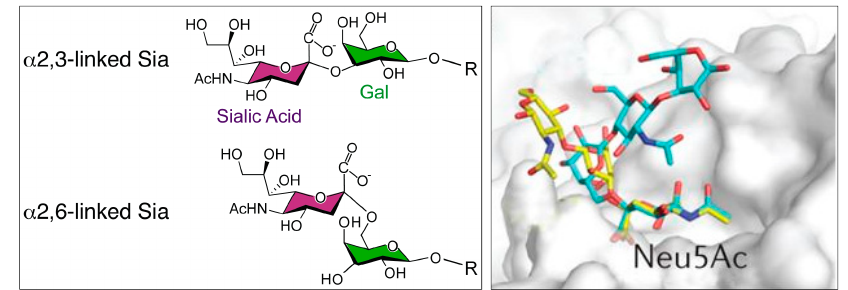
Figure 1. ( Left ): Structure of N -acetylneuraminic acid (Neu5Ac, sialic acid, SA), linked to galactose either via a α -2,3- or via a α -2,6-linkage. Figure taken from [18], which is an open access article distributed under Creative Commons attribution license. ( Right ): Superposition of an avian influenza virus hemagglutinin in a complex with α -2,3-sialyllactosamine (yellow) (PDB accession 2WR2) and the human receptor α -2,6-sialyllactosamine (cyan) (PDB accession 2WR7). The avian receptor generally has a linear conformation, whereas the human receptor is more flexible and has an umbrella-like topology. Reproduced with permission from [14]. Copyright Nature, 2014.